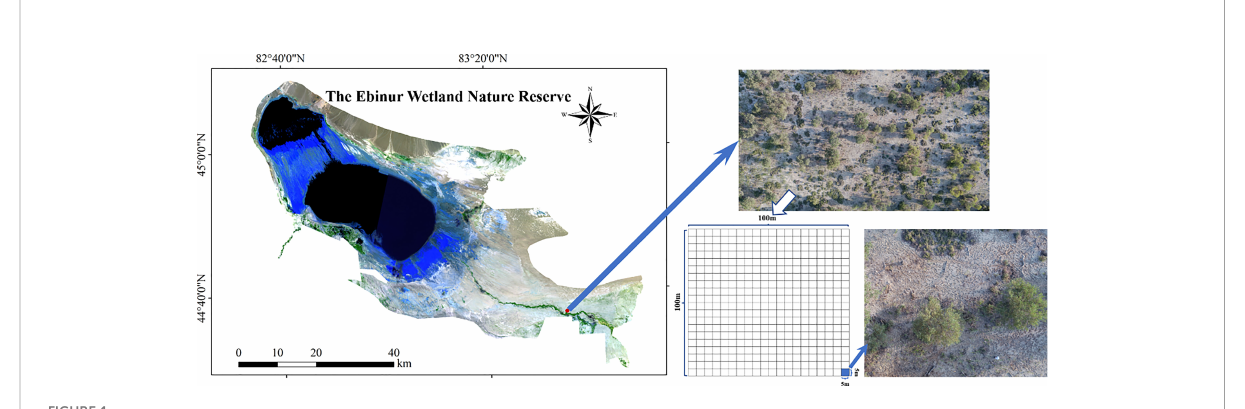
FIGURE 1 Sampling sites and the division of 1 ha sampling plot.